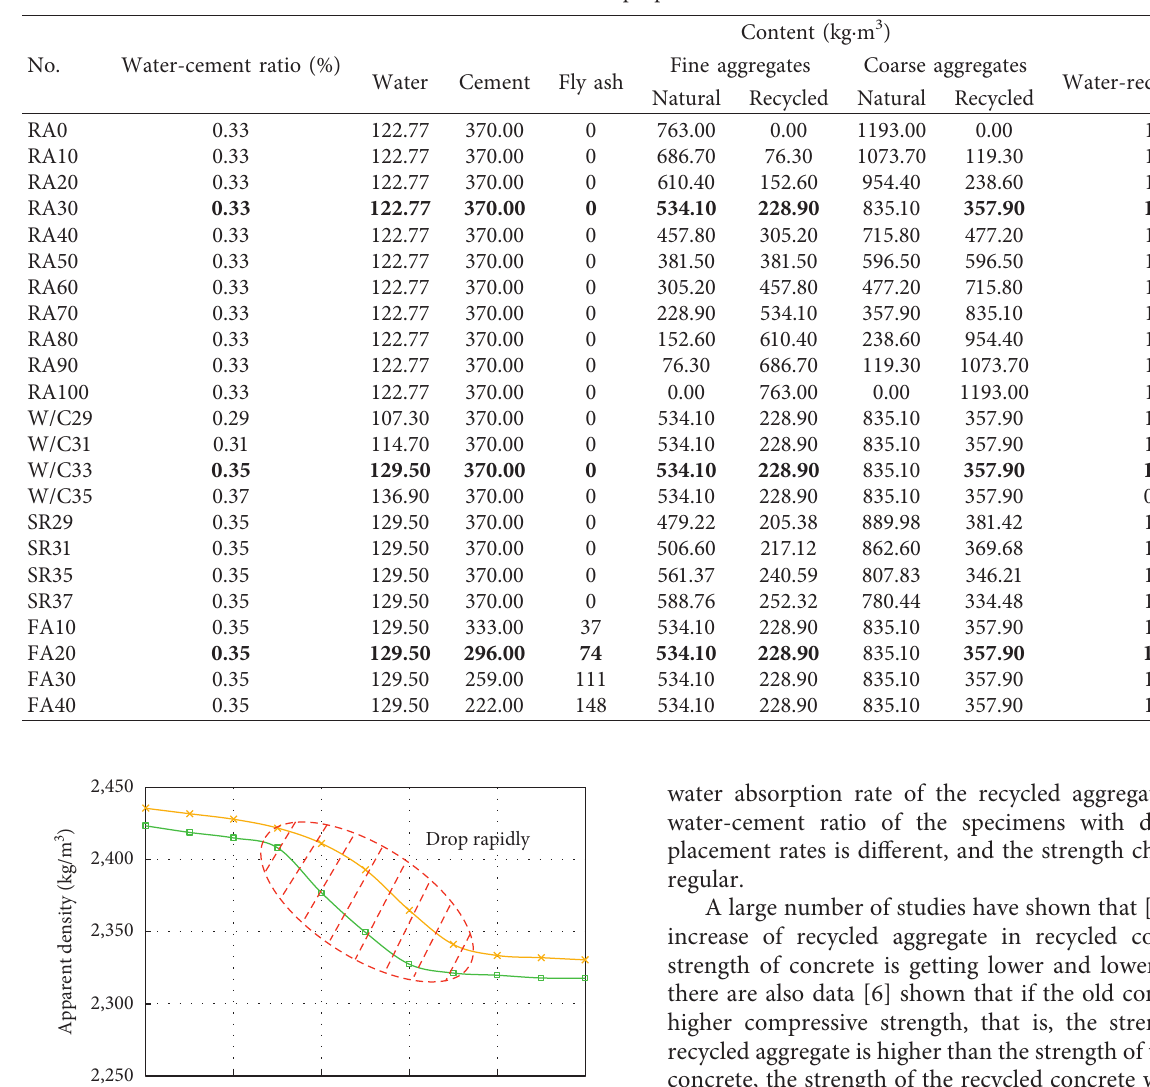
Table 3: The mix proportion of concrete.